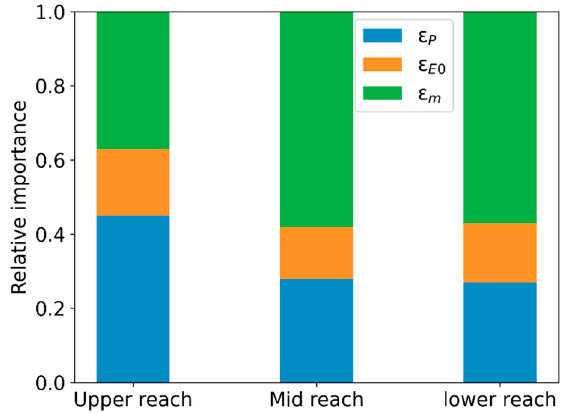
Figure 3. Relative importance of P (stacks at the bottom), E 0 (stacks at the middle), and other factors (stacks at the top) across the subzones of the Urumqi River basin.